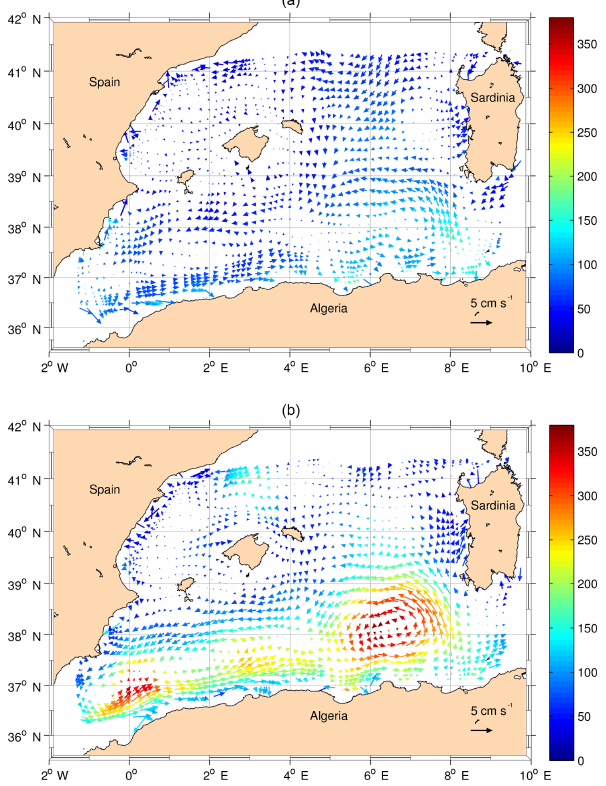
Figure 18. Average velocities in cms − 1 of the cyclonic (a) and anticyclonic (b) eddies in boxes of 1 / 5 ◦ . The colour indicates the average daily EKEs (cm 2 s − 2 ) in the same